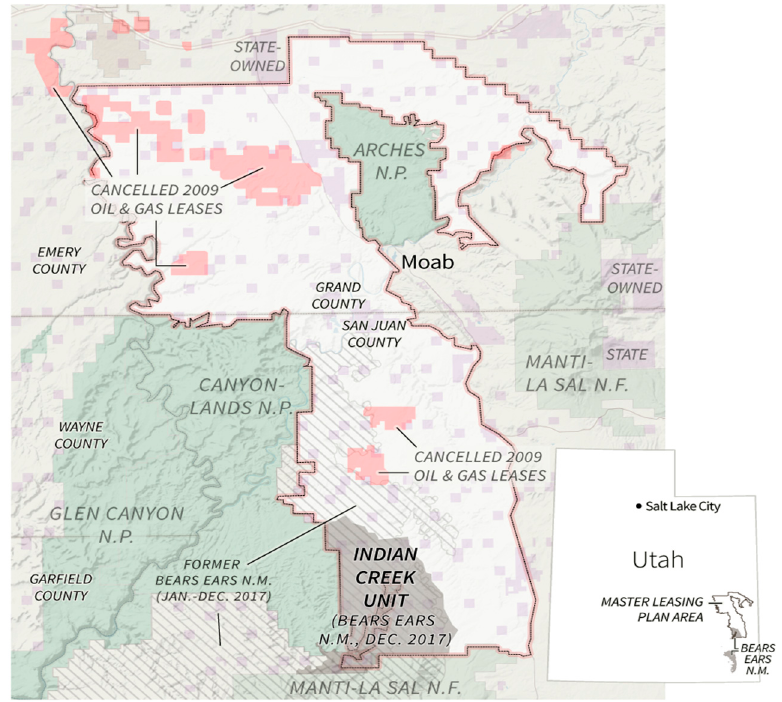
Figure 2. Map of Canyonlands National Park and Arches National Park, as well as nearby Bureau of Land Management (BLM) and Forest Service Lands. Source: Geoff McGhee, Bureau of Land Management.